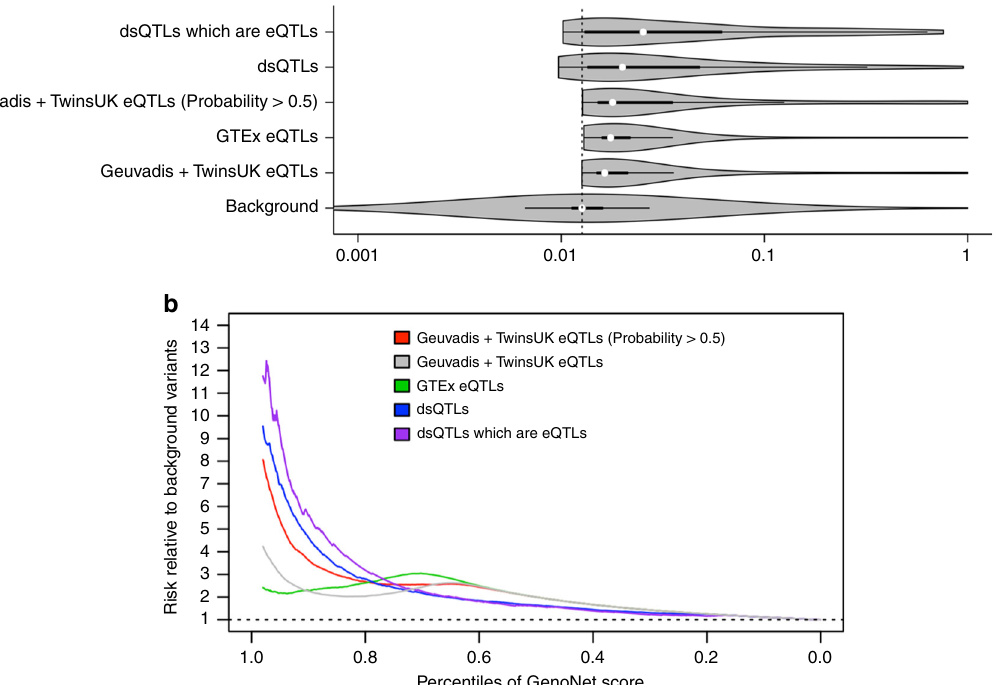
Fig. 5 Enrichment analyses using eQTLs/dsQTLs. a Violin plots comparing the distributions of GenoNet scores for different sets of eQTLs or dsQTLs identi fi ed in previous studies. b Each curve represents the probability of a variant being eQTL or dsQTL, conditional on its GenoNet score being greater than a given percentile, relative to randomly selected background variants. We note that because only a small subset of eQTLs have high GenoNet scores in these datasets, the estimation of the relative risk in the tails can be